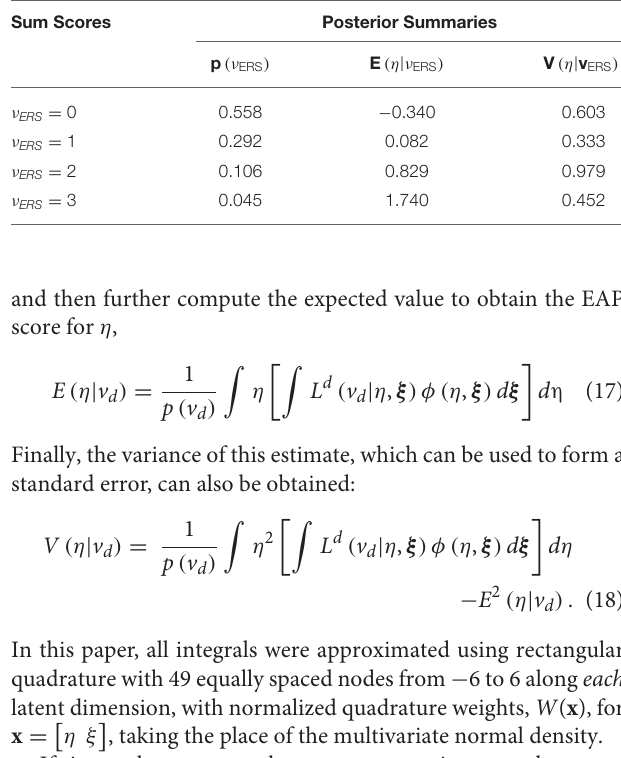
TABLE 9 | Final score and variance